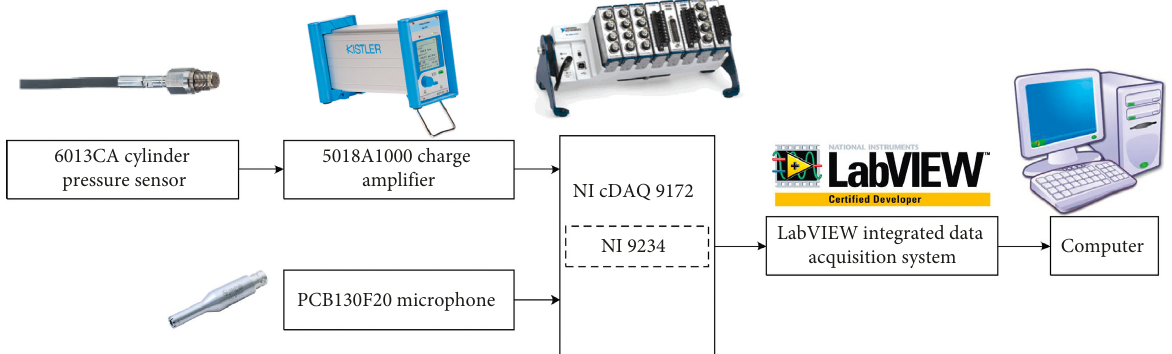
Figure 10: The internal combustion engine measurement system.